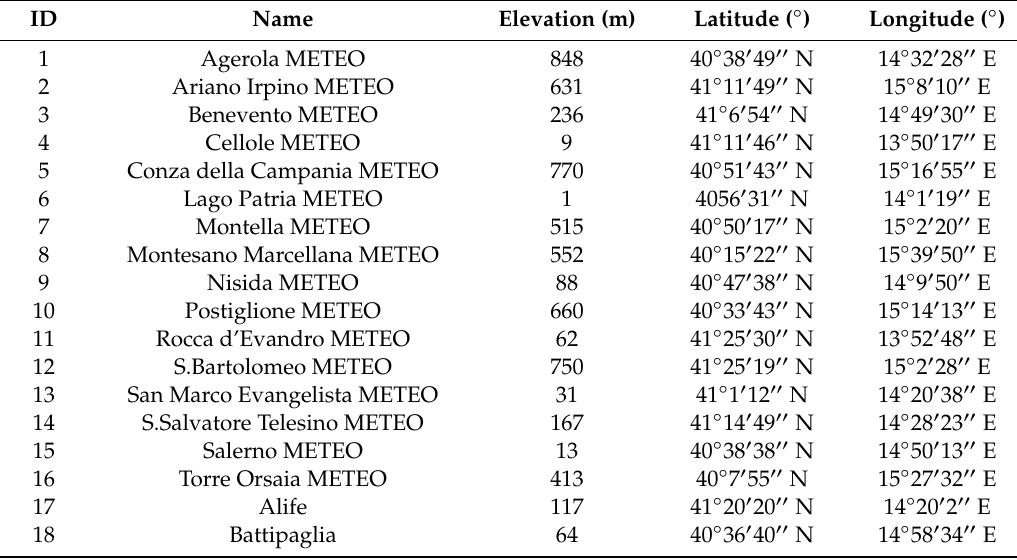
Table 1. List of the ground weather stations in the study area.